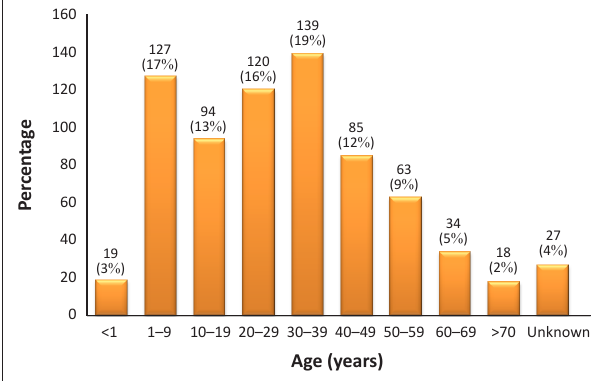
FIGURE 1: Summary of age distribution.